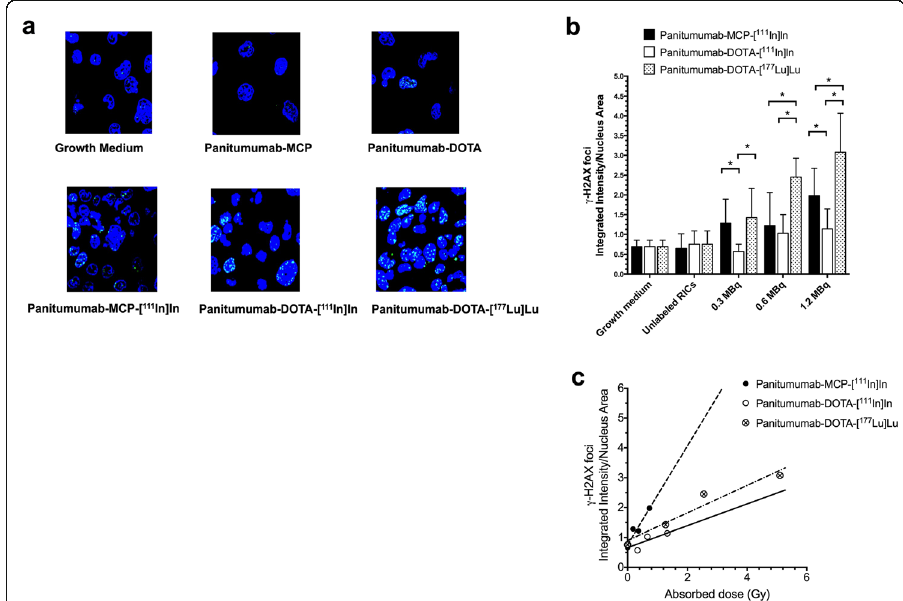
Fig. 2 a Representative immunofluorescence microscopy images of PANC-1 cells exposed to growth medium, unlabeled panitumumab-MCP or panitumumab-DOTA or 1.2 MBq (2.5 nmoles/L) of